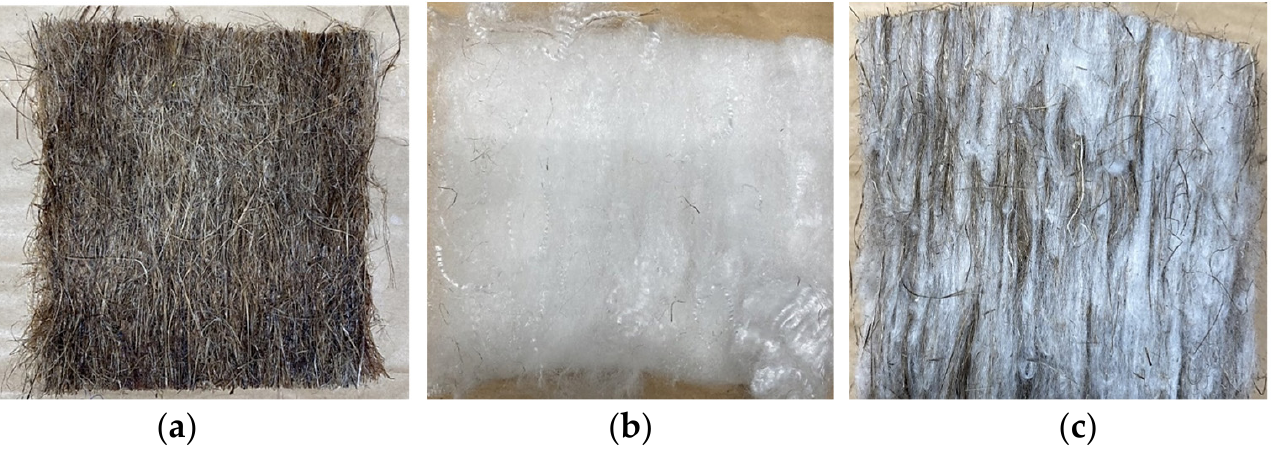
Figure 3. ( a ) Hemp fiber mats with Palonot; ( b ) carded PLA fiber mat; ( c ) carded mix of hemp (50 wt.%) and PLA fibers without F1.